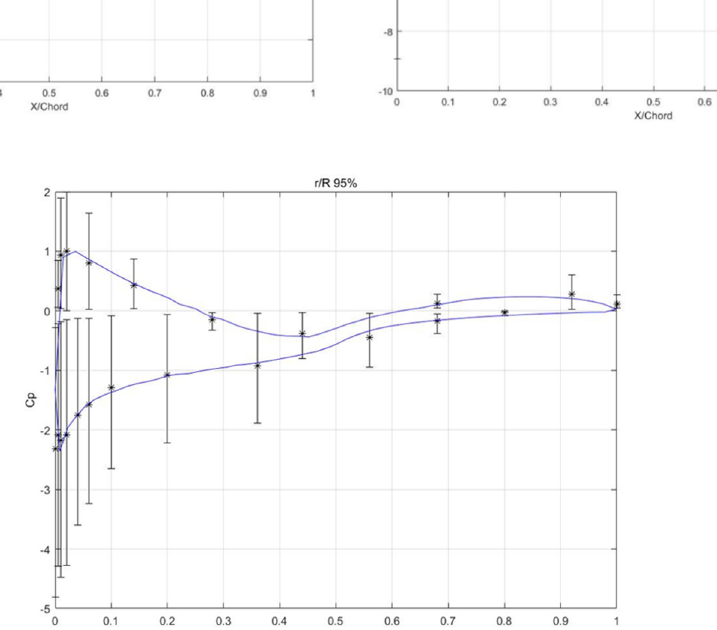
Figure 14. Pressure coefficients distribution for 10 m/s wind speed.